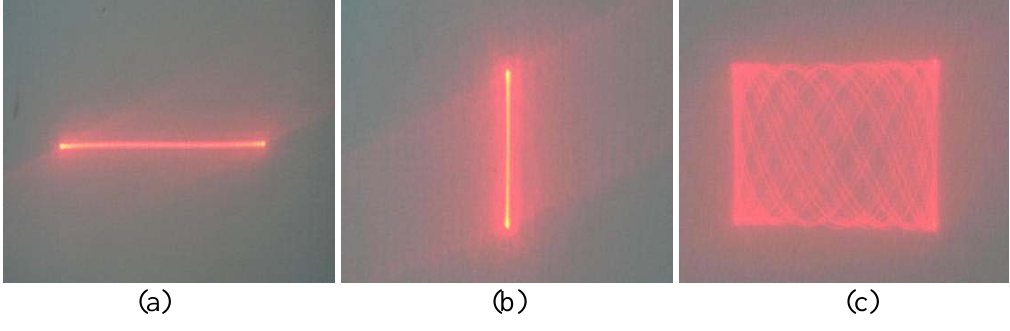
Figure 9. Scan patterns of two-dimensional scanning micro-mirror. (a) Twisting by y-axis, (b) Bending by x-axis, (c) Two-dimensional scan.